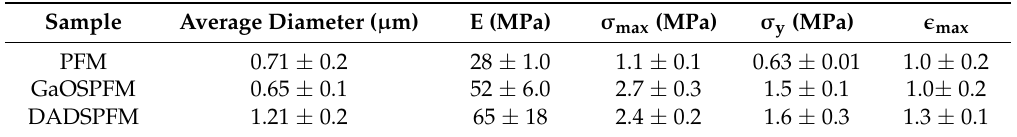
Table 1. Average diameter values and mechanical properties of the produced neat and functionalized PFM.